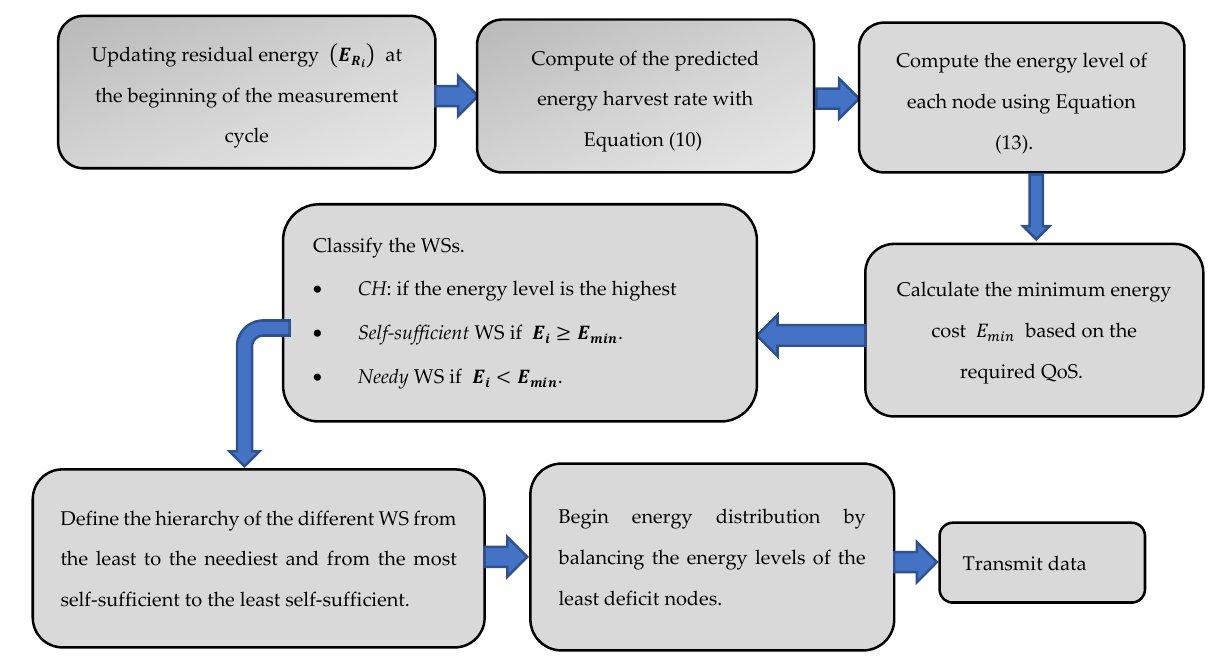
Figure 13. HEBP design stage.